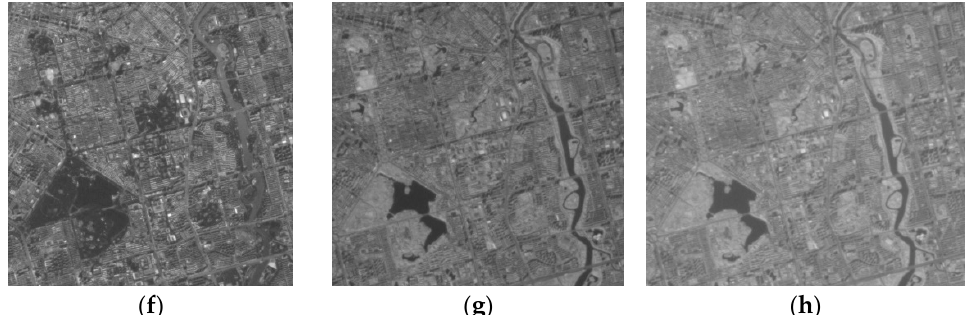
Figure 9. The image of Changchun City in Jilin Province captured in orbit. ( a ) The true color image composed of 486 nm, 548 nm, and 668 nm; ( b ) the false color image composed of 686 nm, 760 nm, and 835 nm; ( c ) the image of 486 nm; ( d ) the image of 548 nm; ( e ) the image of 668 nm; ( f ) the image of 686 nm; ( g ) the image of 760 nm; ( h ) the image of 835 nm.